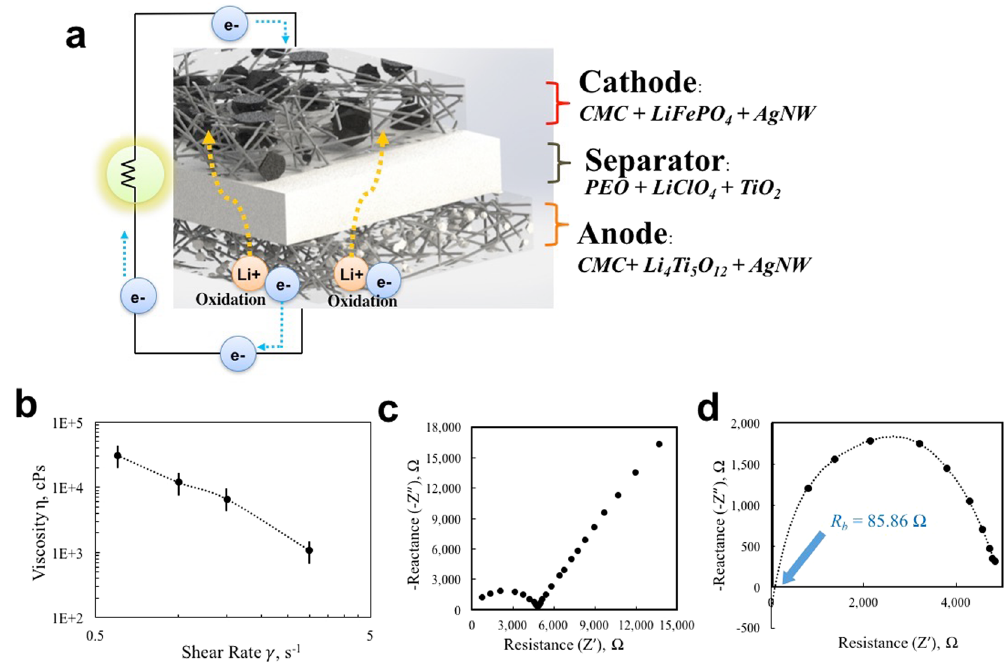
Figure 3. Design of Printable Pastes for Battery Components and Ionic Conductivity of Printable Electrolytes. ( a ) Schematic overview of 3D printed battery. Larger black particles represent LFP particles while smaller white particles represent LTO particles, ( b ) Viscosity change of anode paste with increasing shear rate. The anode paste displays strong shear thinning behavior which benefits the 3D printability. Nyquist plot of PEO-LiClO 4 - TiO 2 electrolyte, ( c ) Impedance of the electrolyte with different frequency values from 20 Hz to 2 MHz, ( d ) Zoomed in plot at high frequency region. Dotted trend line is drawn to approximate the bulk resistance R b of the